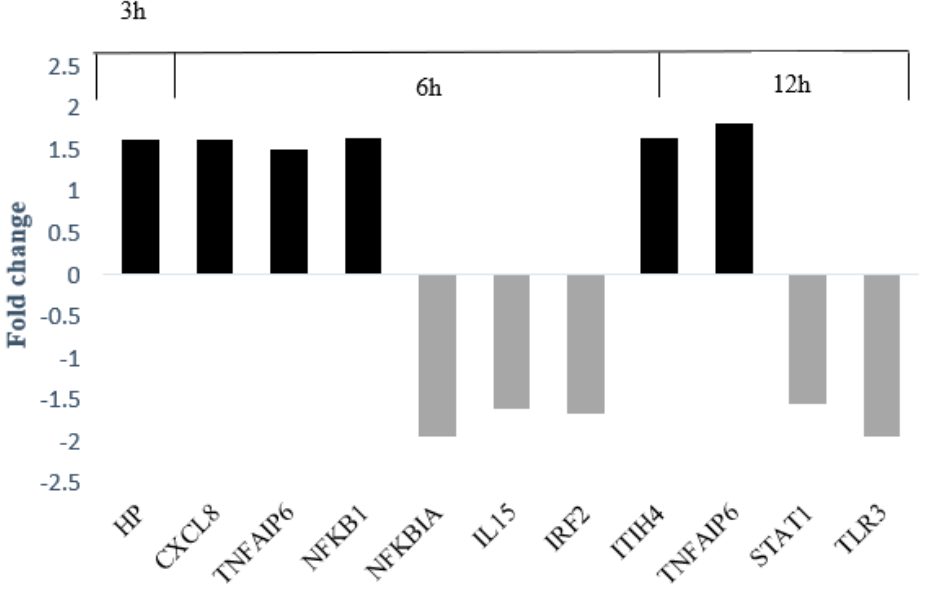
Figure 3. The FC of the key